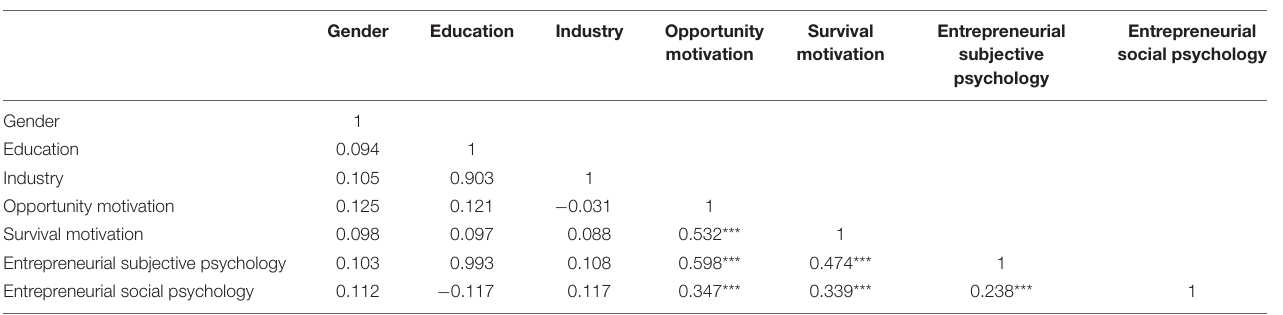
TABLE 2 | Correlation